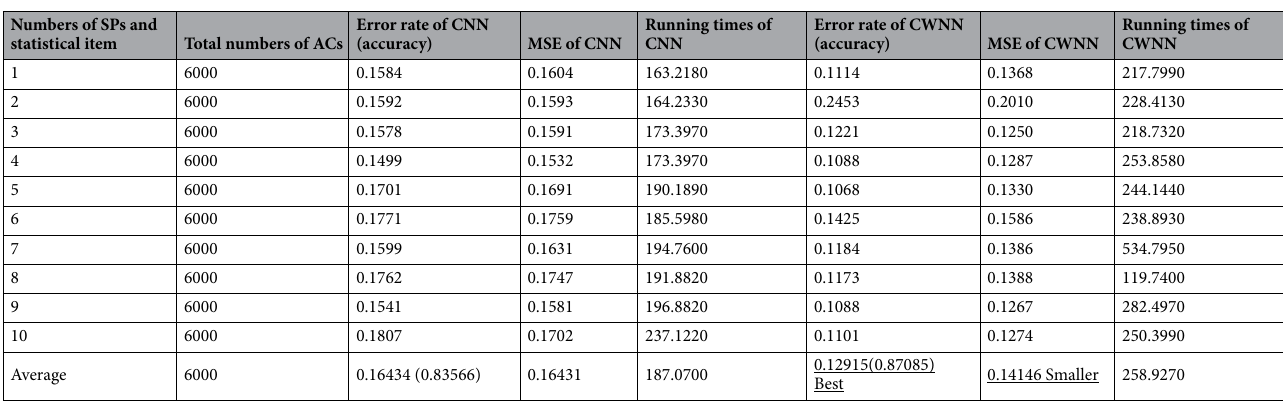
Table 3. Simulation results of CNN and CWNN on MNIST. Underlined values represent the results with the highest accuracy or the lowest mean square